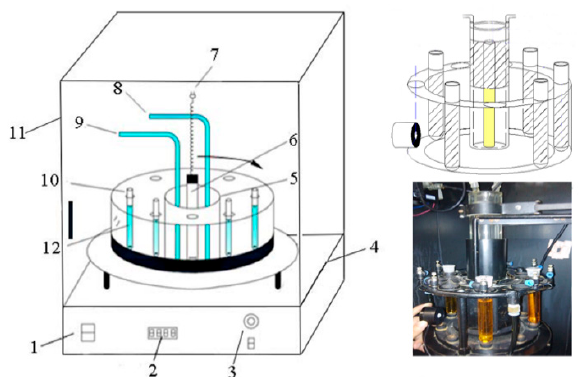
Figure 1. Schematic illustration of photoreactor. (1. rotary button; 2. temperature display; 3. magnetic stirrer button; 4. lampstand; 5. quartz vessel; 6. UV lamp; 7. power plug; 8. cooling water inlet; 9. cooling water outlet; 10. quartz tube reactor; 11. cover; and 12. reaction solution).